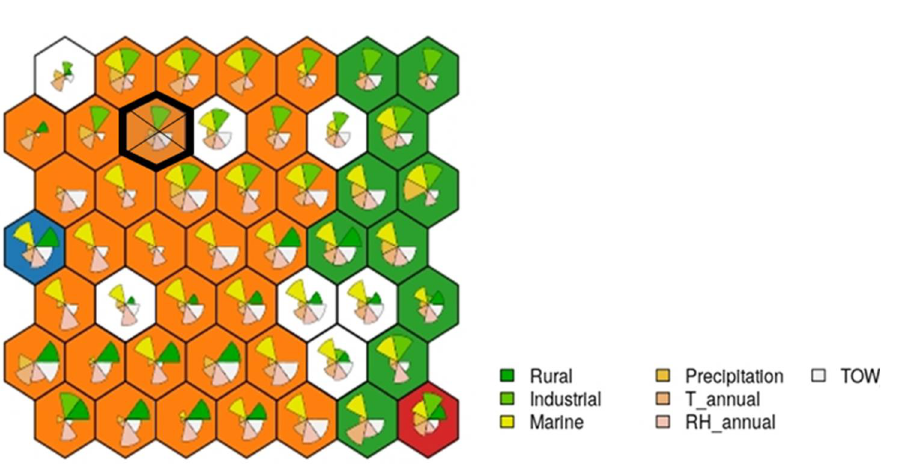
Figure 12. Case study example: the cake portions shown at each node show the contribution of each variable; the larger the size, the greater its final weight.